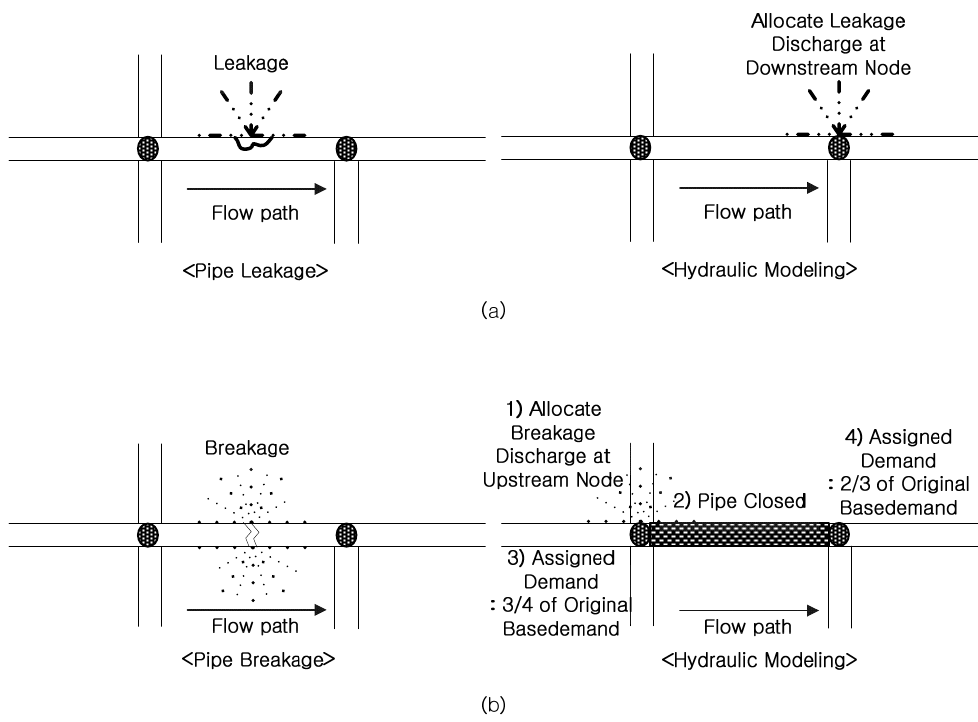
Figure 2. A schematic diagram to describe pipe damage modeling: ( a ) leakage condition and ( b ) breakage condition.